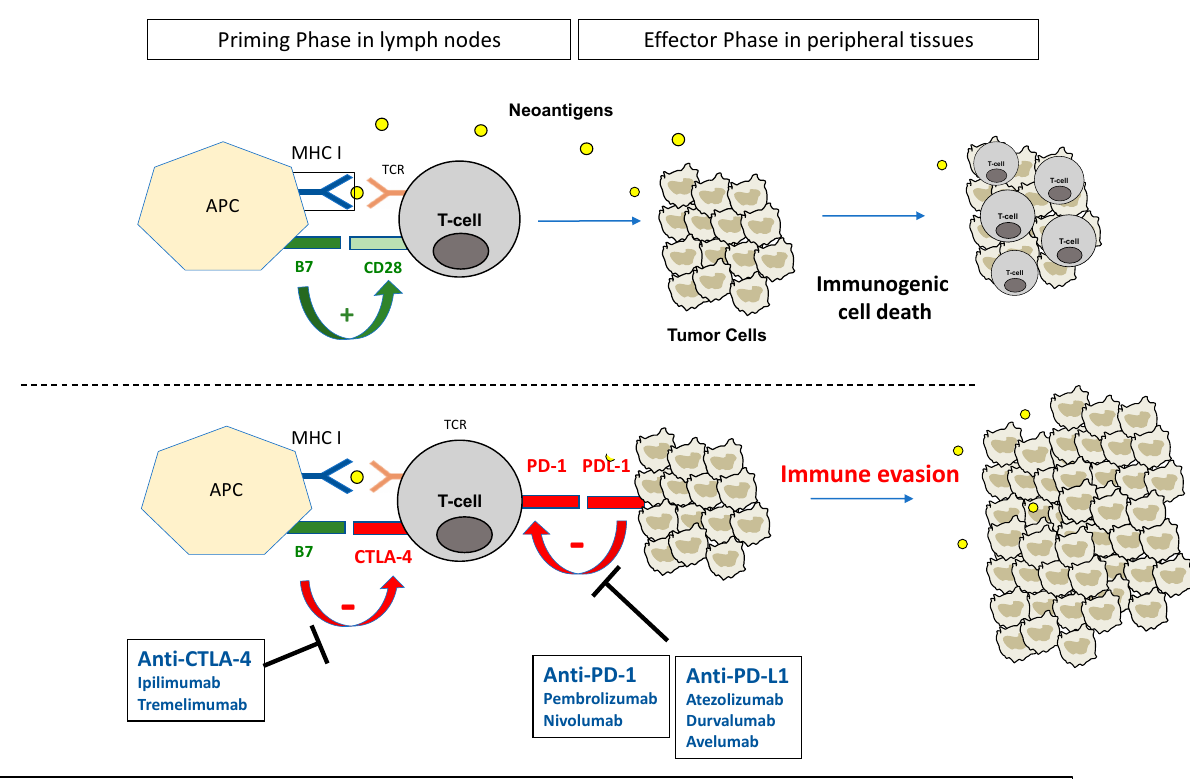
Figure 1. The priming phase consists of the activation of T-cells by antigen-presenting cells (APCs) in lymph nodes. These neoantigens allow the binding of MHCs on APCs to TCRs on T-cells, inducing co-activation signals (B7-CD28) that result in the activation of T-cells. Activated T-cells, in turn,